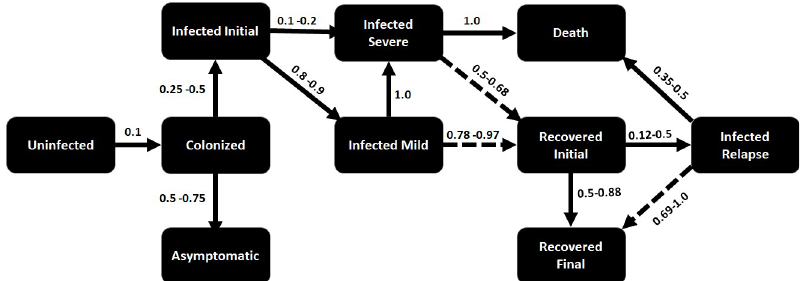
Fig 2. Human infection model for C. difficile . Each state in the finite state machine shown above indicates the stages in the infection/recovery process. The arrows indicate possible transition in state and the weight on the arrows indicate the transition probability. The dashed arrows represent transition under medication.